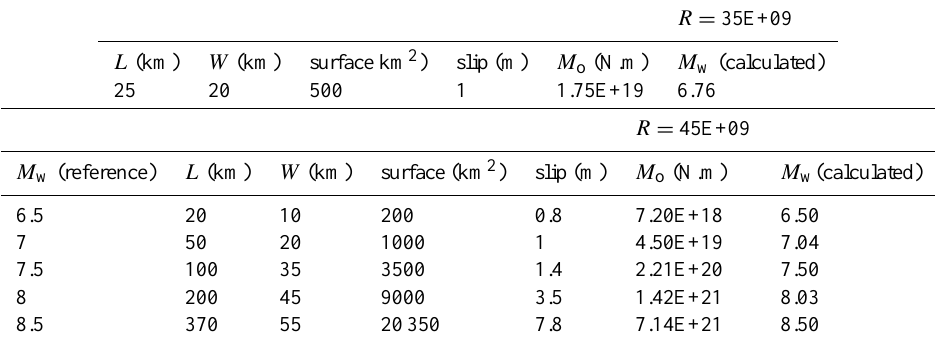
Fig. 12. (a) Location of the epicenter of the El Asnam earthquake of 10 October 1980 (red square), from Roger et al. (2011). (yellow squares) tide gauges that recorded the tsunami; (red dots) local seismicity (USGS data, 1973 to present); (solid black curves) theoretical tsunami travel times for a source located offshore El Asnam area; (blue squares) 1954 Orleansville earthquake and 1928 and 1934 events. (b) Simplified fault base of 25km length segments for the western Algerian margin, the Alboran Sea and the SE Spanish coasts. Each blue segment (with a black dot in its middle) represents the top edge of each 25 × 20km unit source function stored in the precomputed database. Table 3. Source parameters of the scenarios stored in the pre-computed database. 1 (top) for the western Mediterranean basin: 1 earthquake magnitude of M w = 6 . 76 at each source location (bottom) for the NE Atlantic basin: 5 earthquake magnitudes of M w = 6 . 5, 7.0, 7.5, 8.0, and 8.5 at 4each source